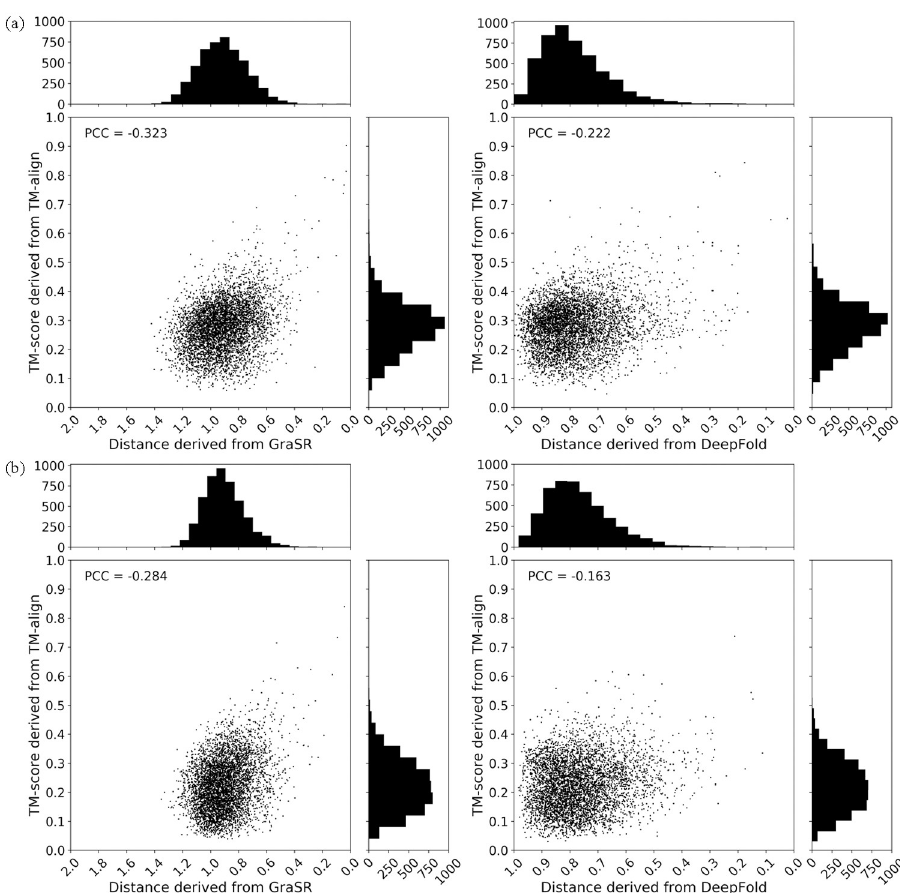
Fig 4. Correlation between distance derived from the representations learned by GraSR/DeepFold and TM-score on (A) SCOPe v2.07 and (B) ind_PDB. The Pearson correlation coefficient (PCC) is calculated for quantitative assessment.